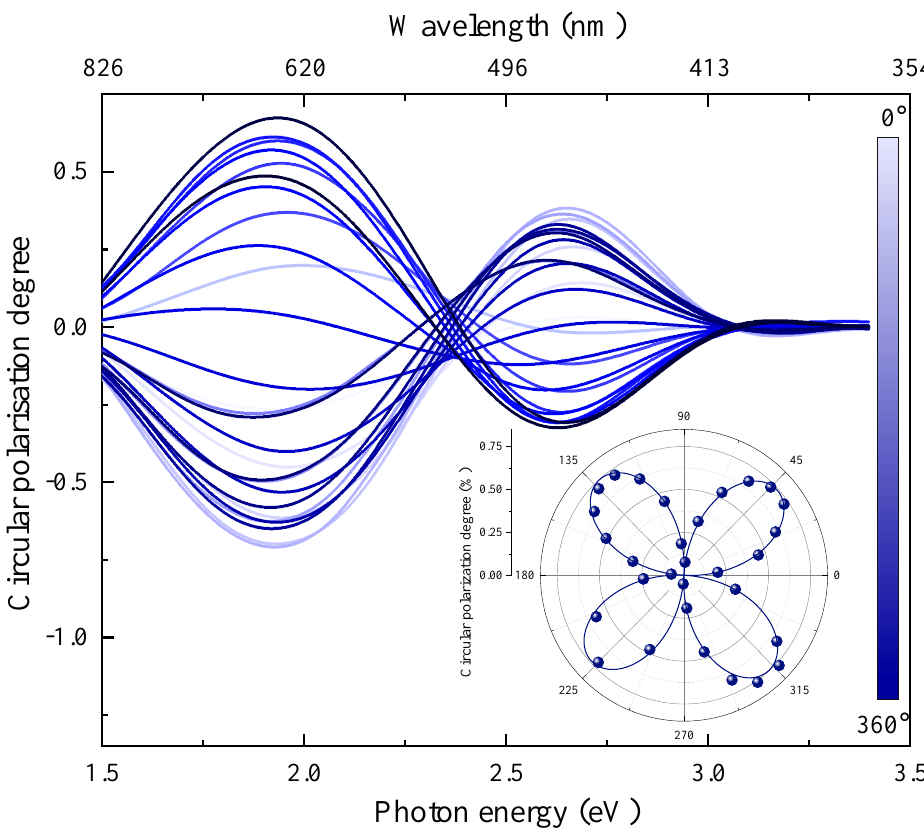
Figure 3. Spectral dependencies of the circular polarisation degree P circ at azimuthal angles from 0 ◦ to 360 ◦ for the light passed through the sample when the incident light was linearly polarised. Spectra were obtained at room temperature. The insert shows the angular dependence of the polarisation